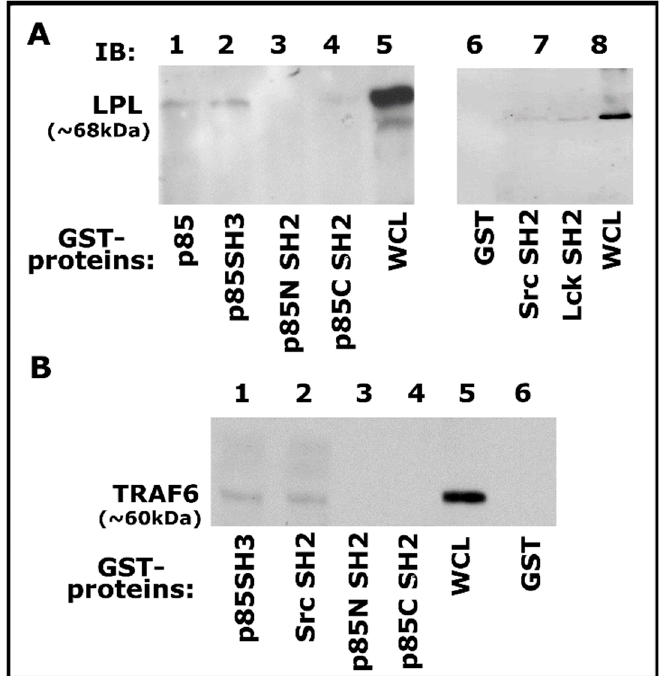
Figure 5. Analysis of binding of proteins (LPL and TRAF-6) with indicated GST-fusion proteins by GST pull-down assay. ( A , B ) Analysis of the specificity of binding of LPL ( A ) and TRAF-6 ( B ) with indicated domains of signaling proteins by GST pull-down assay. Lysate (100 µg) made from osteoclasts treated with TNF- α and bone particles for 3–4 h were used for this assay. The binding of LPL ( A ; ~68–70 kDa) or TRAF-6 ( B ; ~60 kDa) with the GST-fused protein of interest was determined by immunoblotting with the corresponding antibody. Whole-cell lysate (WCL) protein (~25 µg) was used to identify LPL ( A , lanes 5 and 8) and TRAF-6 (lane 5 in B ) proteins. Pull-down with GST (vector protein)-coupled glutathione Sepharose beads was used to determine nonspecific binding ( A , B , lane 6). The experiment was repeated twice, and similar results were obtained. Uncropped autoradiogram images are provided in this figure.